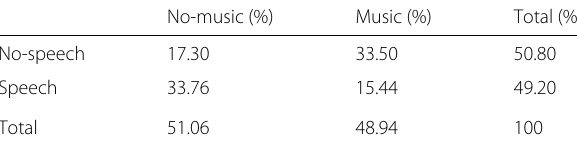
Table 2 Distribution of speech and music events over the unbalanced train segments